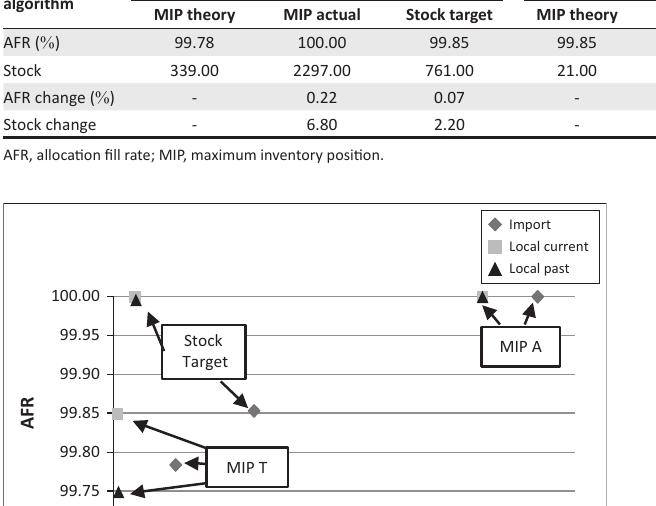
TABLE 3: Simulation results comparing the three order methods in a theoretical environment. Model: algorithm